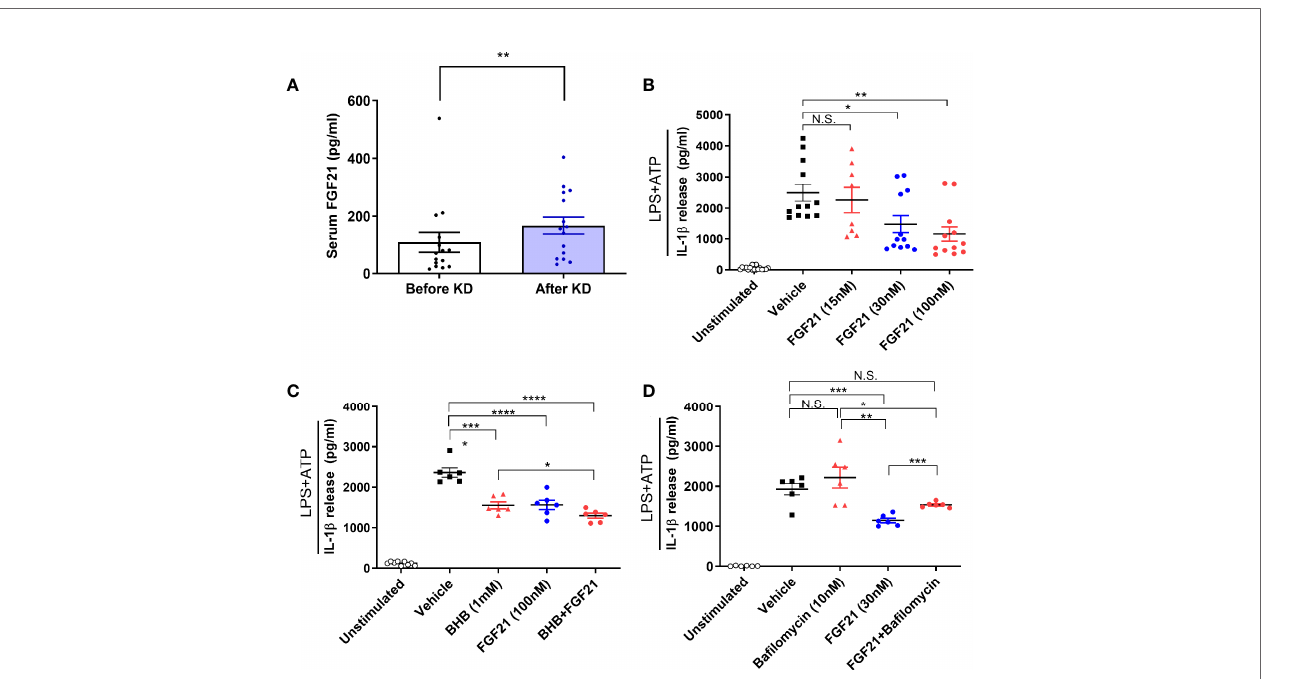
FIGURE 4 | Effects of FGF21 as a mediator of ketogenic diet on NLRP3 in fl ammasome signaling activation in human macrophages. Changes in serum FGF21 levels from baseline to day 3 of isocaloric KD (A) ; ELISA assay measurement of IL-1 b secretion from macrophages primed with 0.1 µg/ml LPS and stimulated with 2 mM ATP in the presence of various dose of FGF21 (15, 30, 100 nM) for 24h (B) , BHB (1 mM), FGF21 (100 nM), or both (C) , ba fi lomycin (10 nM), FGF21 (30 nM), or both (D) . Data are represented as mean ± SEM. One-way analysis of variance (ANOVA) and two-sided paired t-test or Wilcoxon signed rank test; * P < 0.05, ** P < 0.01, *** P < 0.001, and **** P < 0.0001. ATP, adenosine triphosphate; LPS, lipopolysaccharide; FGF21, fi broblast growth factor 21; N.S., non-signi fi cant; KD, ketogenic diet; IL-1 b , interleukin-1 b ; BHB, b